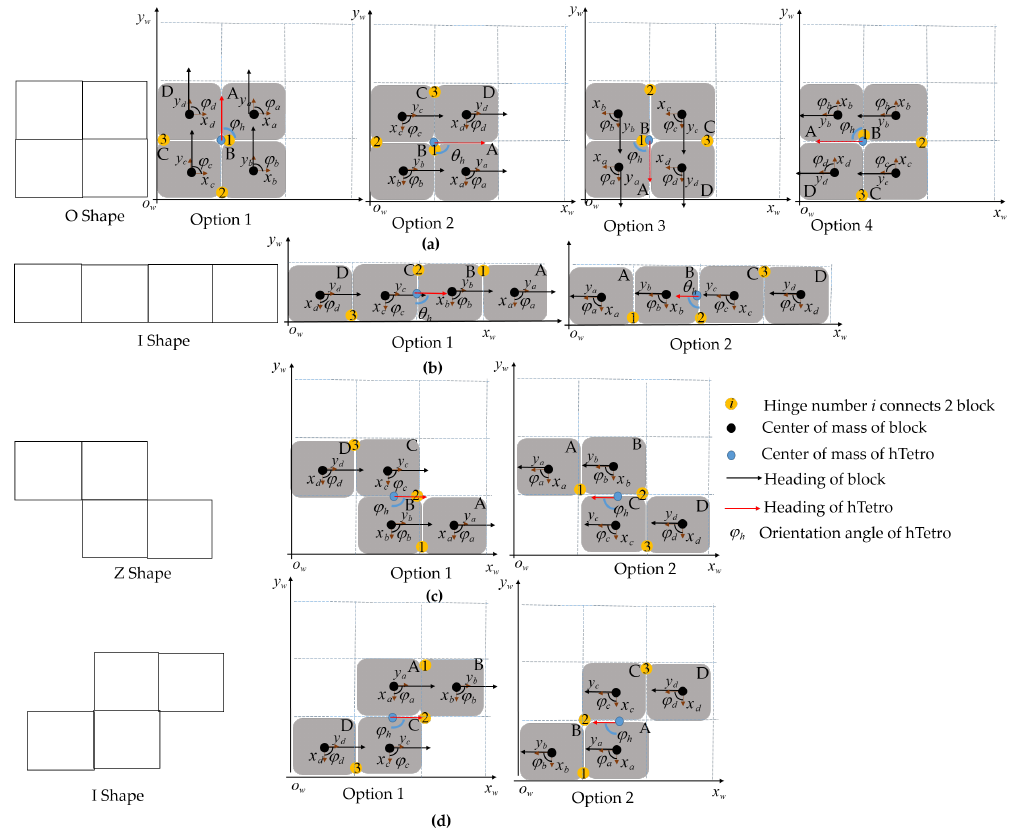
Figure 9. Blocks locations options for symmetrical shapes. ( a ) I morphology, ( b ) O morphology, ( c ) Z morphology, ( d ) S morphology.